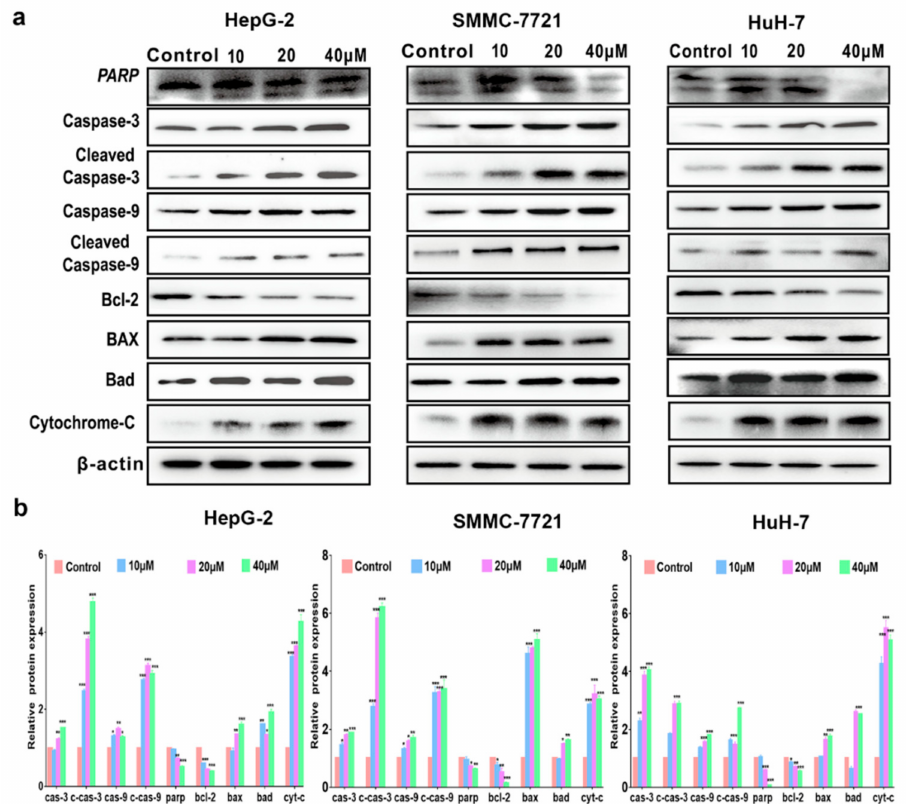
Figure 5. The apoptotic proteins analysis of HCC cells after being treated with compound 1 . ( a ) The expressions of Caspase-3, cleaved Caspase-3, Caspase-9, cleaved Caspase-9, Bcl-2, BAX, Bad, and Cytochrome c were determined by Western blot analysis. β -actin was used as internal control. ( b ) Representative histograms of the apoptotic proteins change. The density ratio of proteins to β -actin was shown as relative expression. Data are represented as mean ± SD of three independent experiments. * p < 0.05, ** p < 0.01, *** p < 0.001, the control compared with the cells treated with compound 1